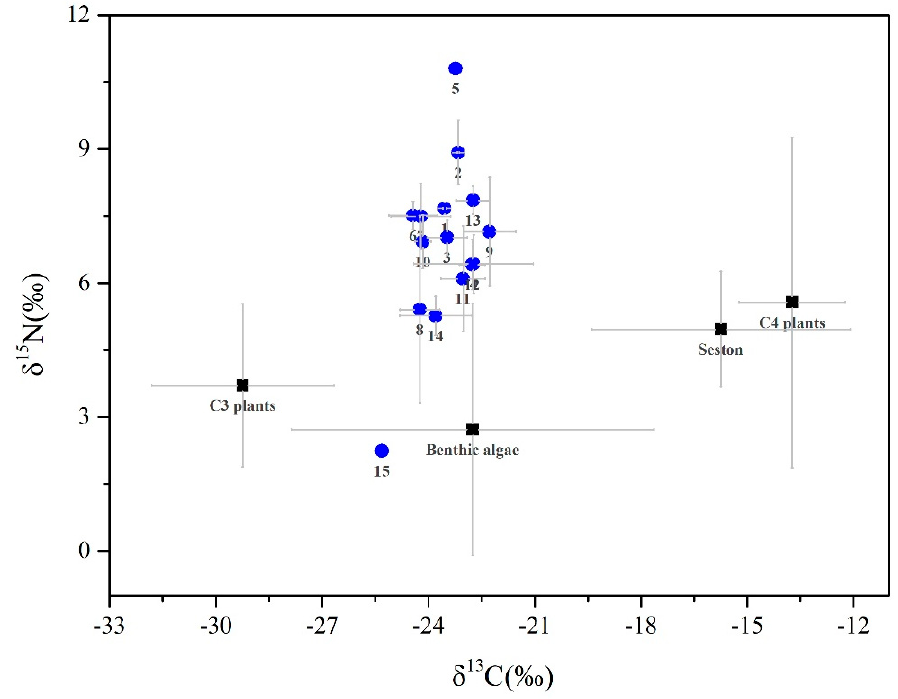
Figure 3. Biplot of δ 13 C and δ 15 N values (mean value and standard deviation) of basal organic carbon sources (black square) and fish (blue dot) collected from the upstream of the Daning River. The fish species code was in accordance with Table 2.